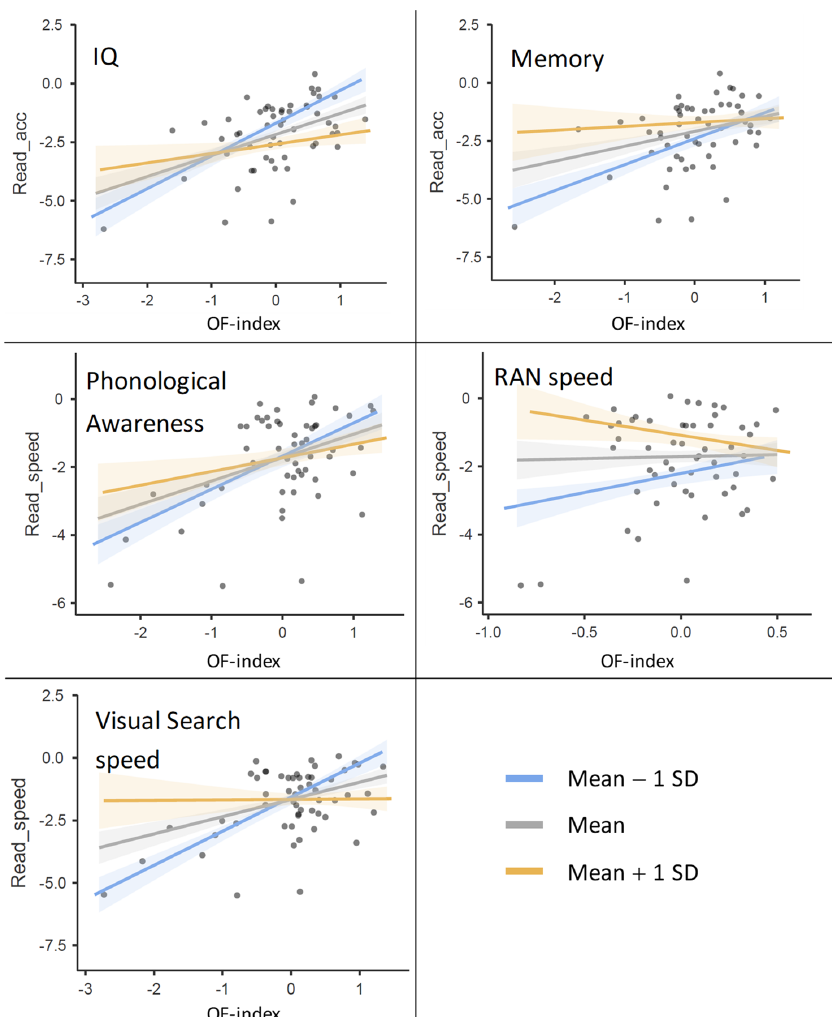
Figure 1. Each plot shows the interaction between one specific predictor (named in the top ‐ left corner of the plot) and other predictors in determining reading performance. The latter was measured in terms of either reading accuracy (“acc”) or reading speed, and is reported as a z ‐ score on the vertical axis. Dots represent single participants. The specific predictor varies across colors (different regression lines in the plot), while the other predictors are shown as a composite score, the “other factors” (OF) index, reported on the horizontal axis (see text for computational details). For instance, the first plot reports the effect by predictors other than IQ as the slope of the regression lines, and the separate regression lines show different levels of IQ: the gray line shows performance by subjects whose IQ was at the sample mean, the blue line shows performance by subjects whose IQ was 1 SD below the sample mean ( − 1 SD), and the yellow line shows performance by subjects whose IQ was 1 SD above the sample mean (+1 SD). Shaded regions around the regression lines show the standard error of the mean [73]. In all cases, the effect of the single predictor (visible as the gap between the yellow and the blue line) is significantly amplified when other cognitive performances are low (low OF index, on the X